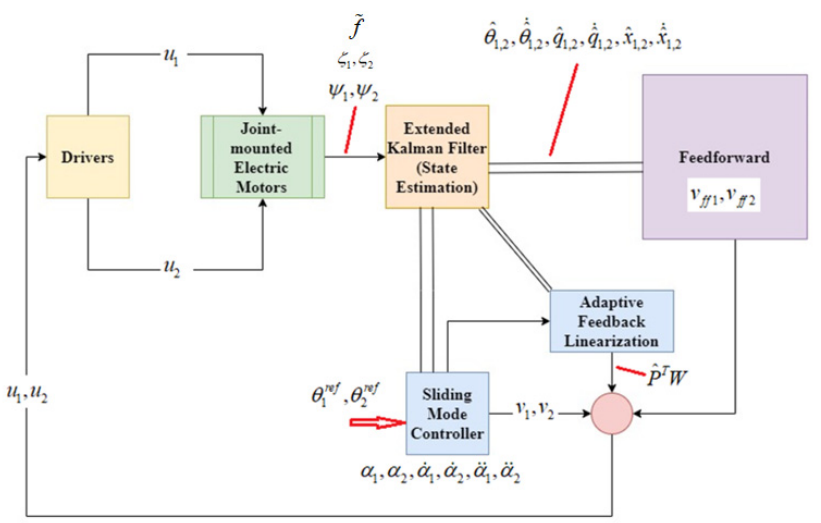
Figure 3. General block diagram of the proposed control system.